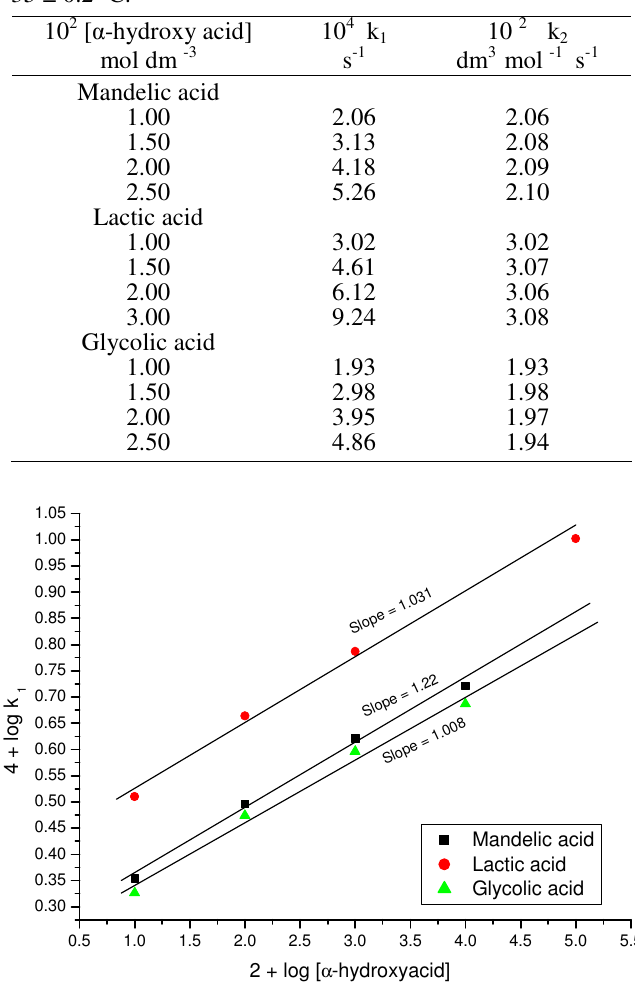
Figure 5. Dependence of rate on [ α -hydroxyacid ] in CTAB Comparison of rates on oxidation of pentaamminecobalt(III) complexes of both bound and unbound α -hydroxyacid by H O 2